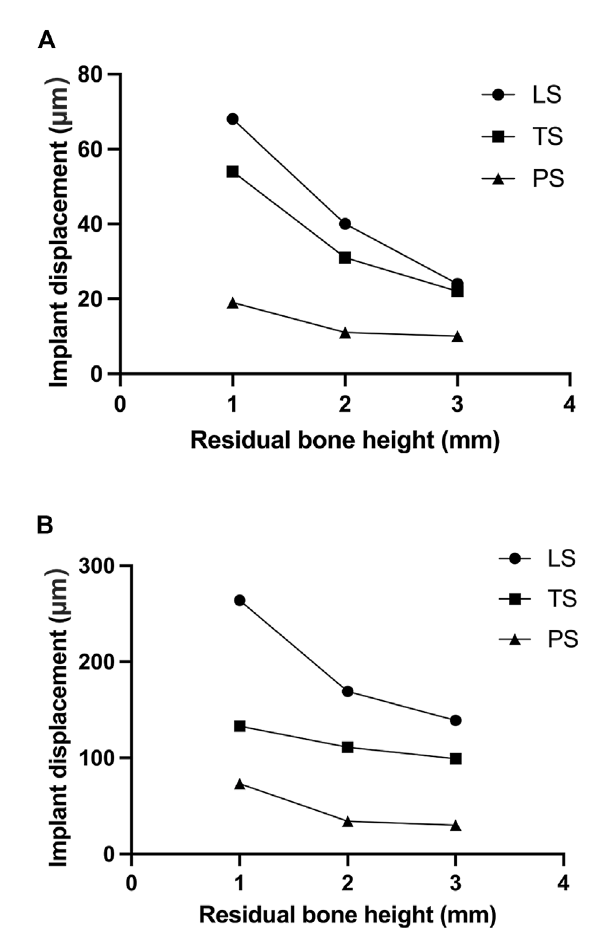
Implant displacement changes of different residual bone heights and different wing designs under forces in different directions; (A) 0 ° ; (B) 45 ° .